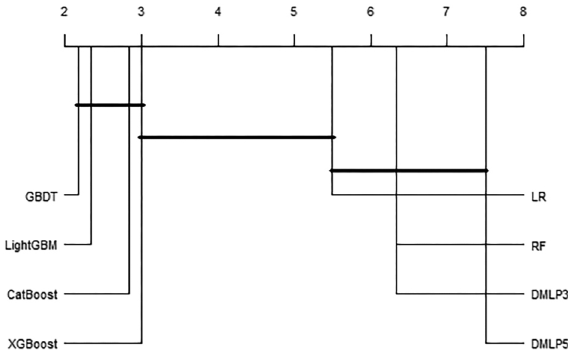
Figure 3. Critical difference plot of competing models over the average rank of capital charge error measures (significance level = 0.05). The models within the bold lines exhibit no significant difference in average